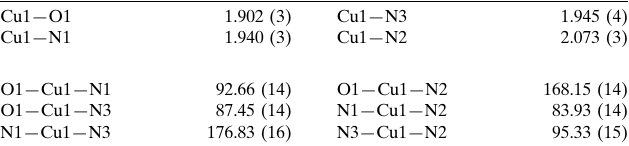
Selected geometric parameters (A˚ , (cid:1)